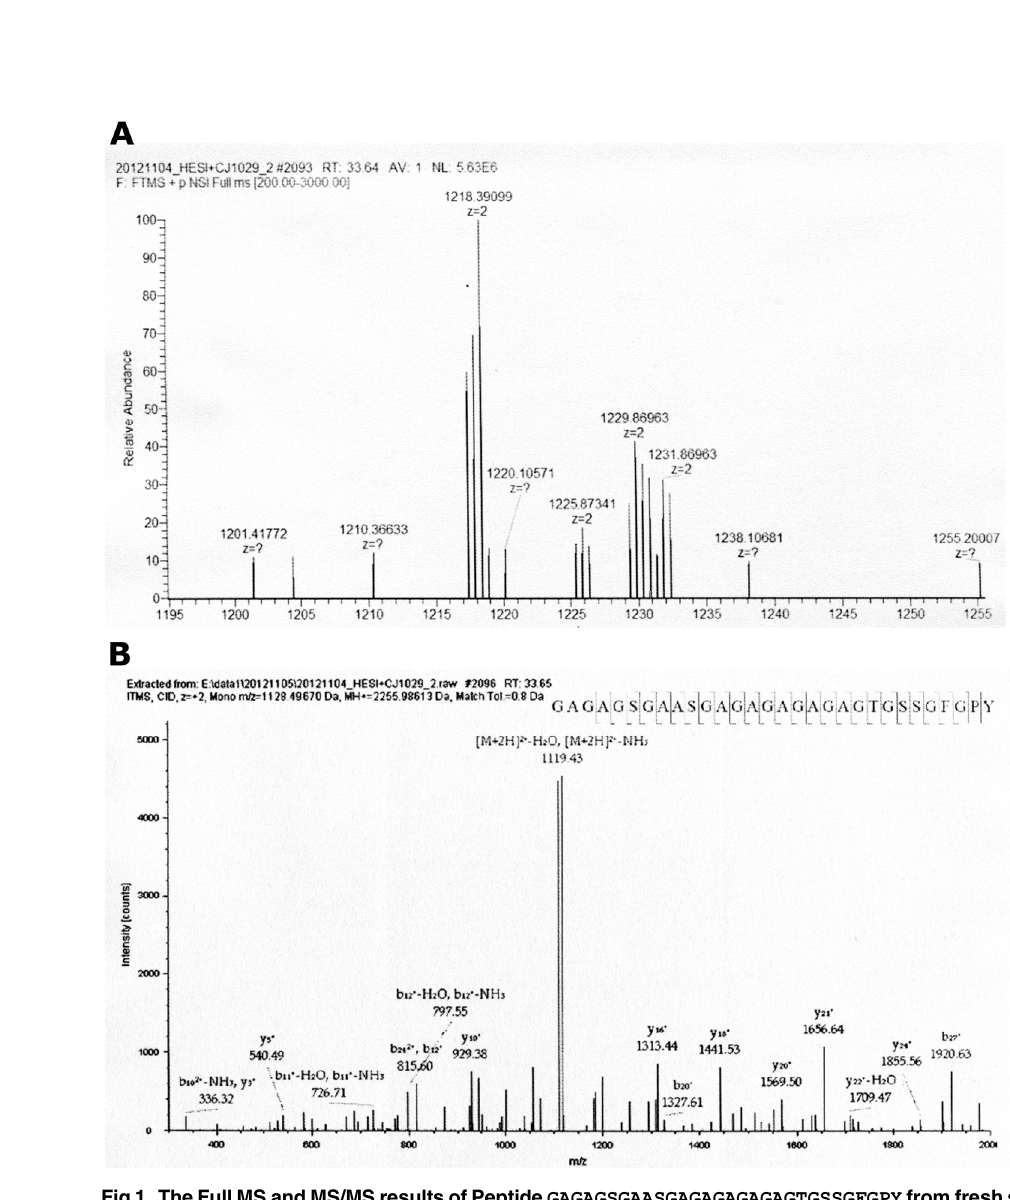
Fig 1. The Full MS and MS/MS results of Peptide GAGAGSGAASGAGAGAGAGAGTGSSGFGPY from fresh silk in Table 1. (A) The full MS data. (B) The b-type and y-type ion fragments of the peptide after CID in